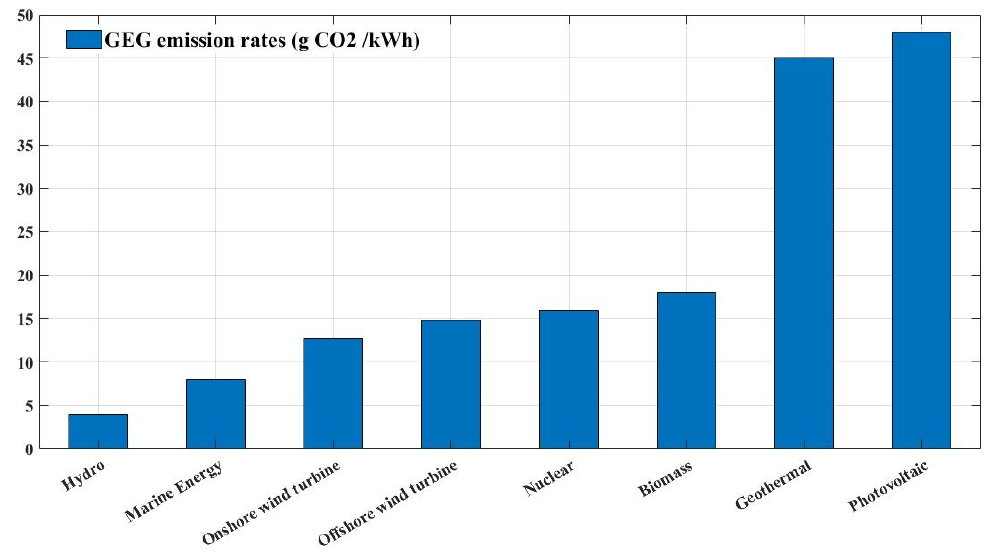
Figure 3. GEG emissions rates for different power sources.